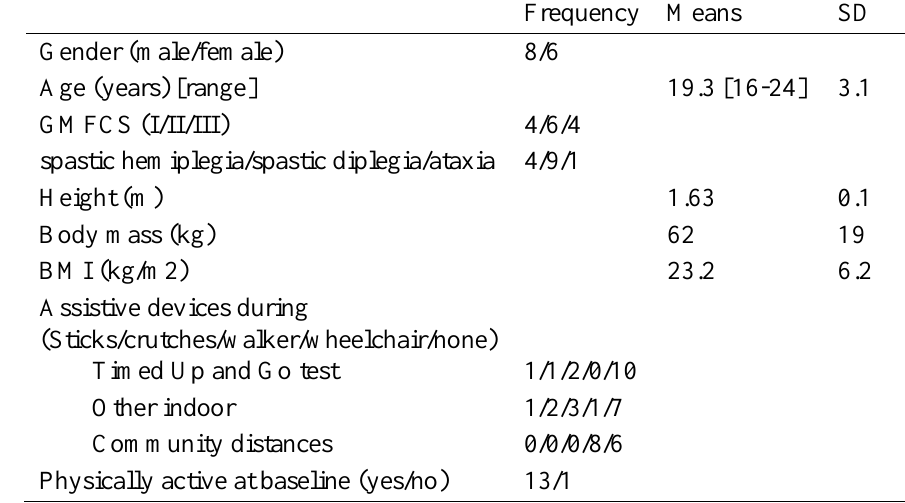
Table 1 . Characteristics of the participants who started the study